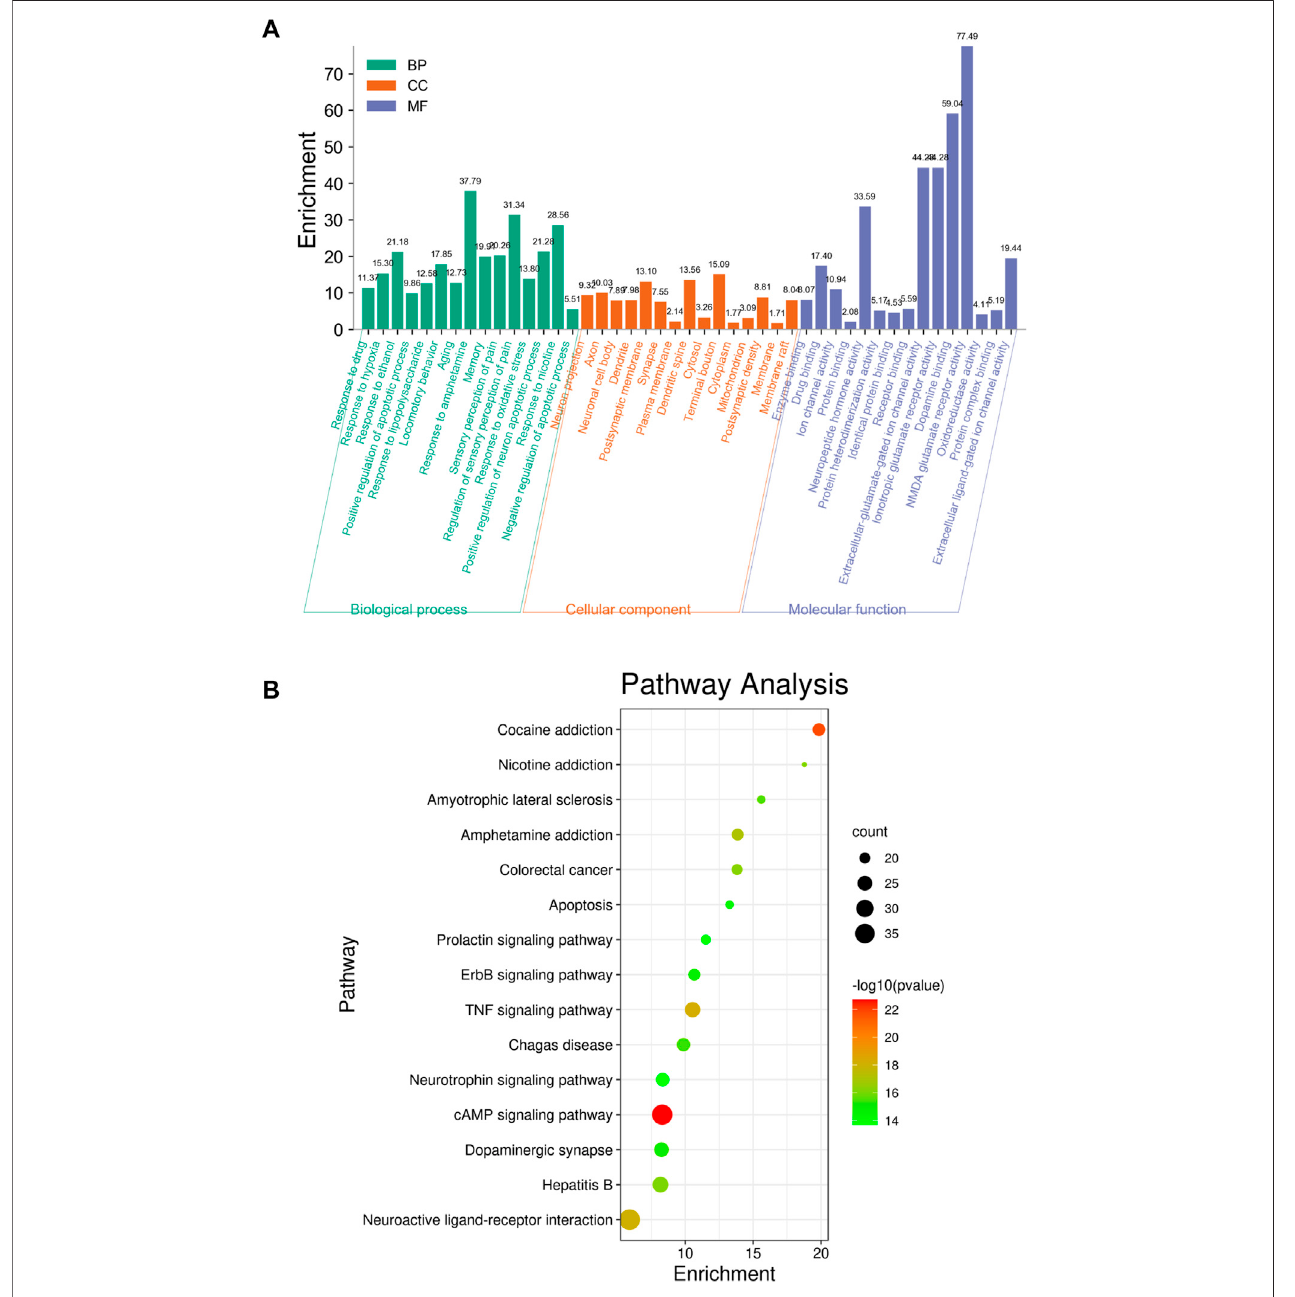
FIGURE 4 | Top 15 signi fi cantly enriched terms gene ontology (A) and pathway enrichment (B) analyses of potential target genes of krill oil on METH-induced memory de fi cits.